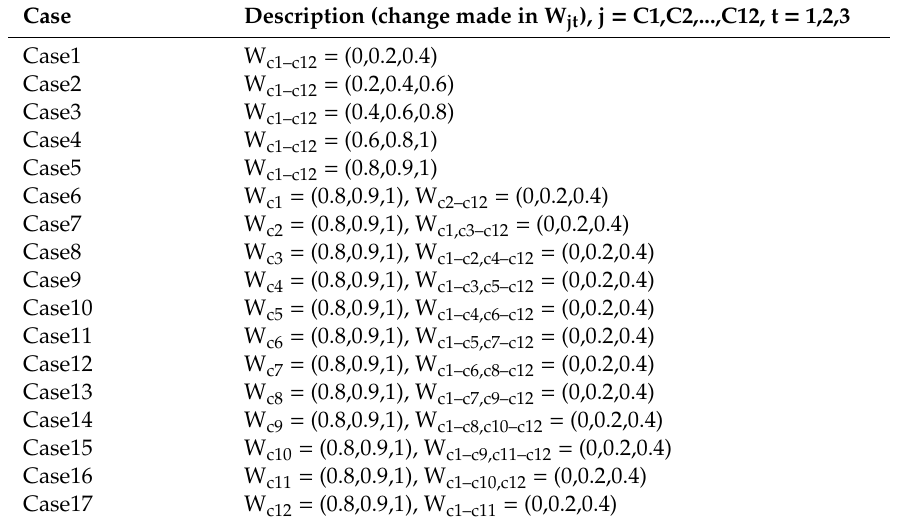
Table 19. Details for sensitivity analysis.